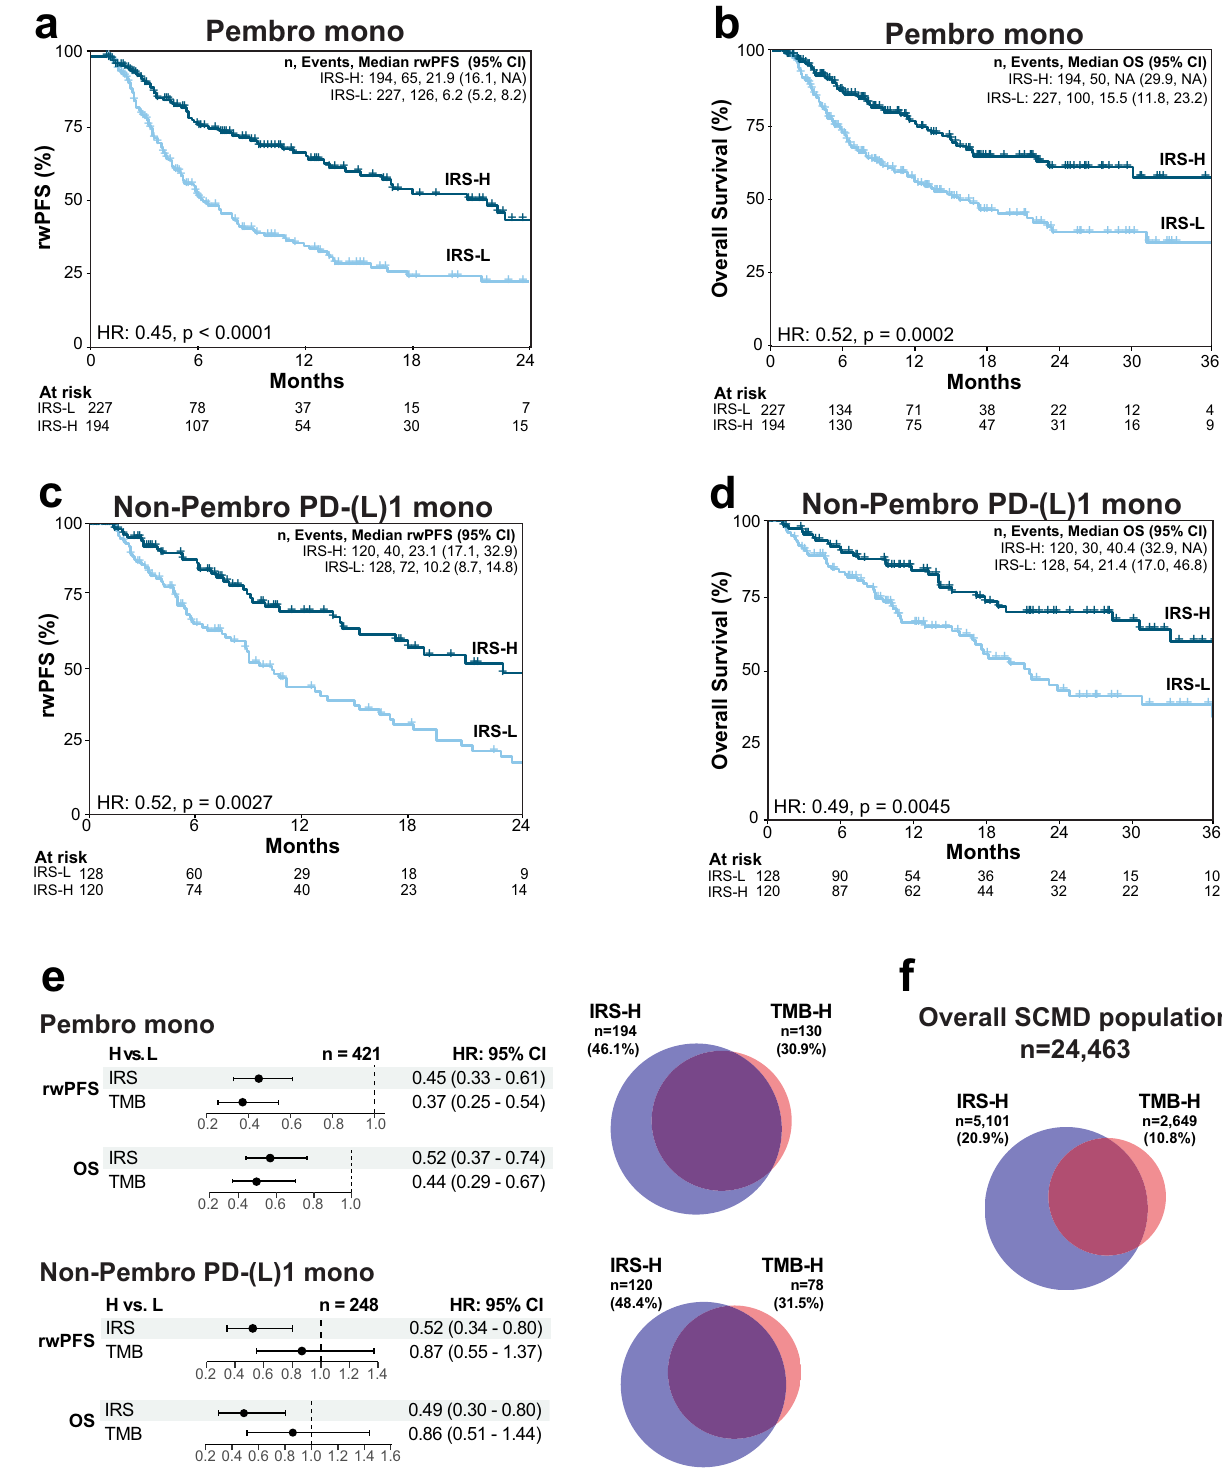
monotherapy treatment bene fi t. As described in the Supplemen- tary Results and Fig. S13, CDKN2A deep deletion (homozygous loss) status, which has improved upon TMB alone for predicting monotherapy PD-(L)1 bene fi t in two recent studies 59,60 , was not additive to IRS, further supporting the limitations of genomic markers alone for predicting PD-(L)1 therapy